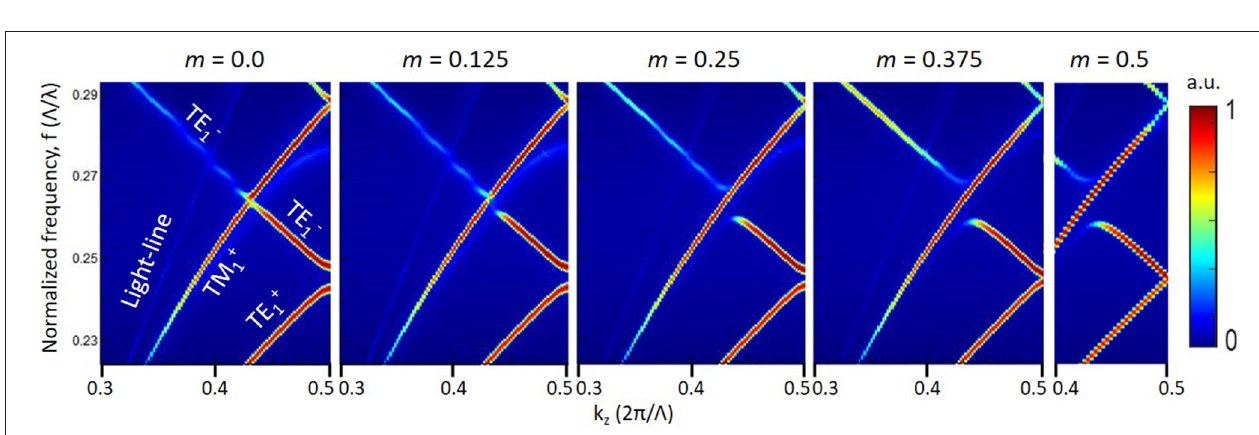
FIGURE 4 | Dispersion relations of horizontal-slot fin-waveguide with mismatch parameter, m = 0.0–0.5. Design: 3 = 400 nm, fill-factor =